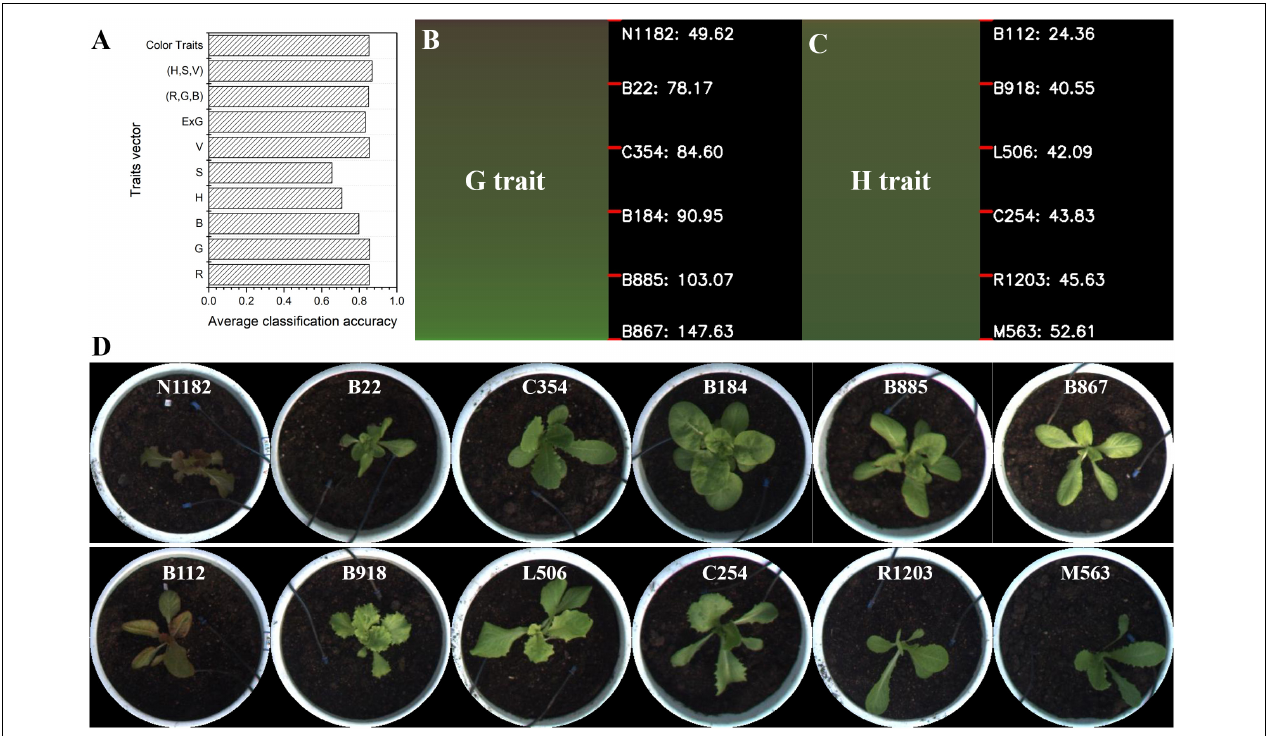
FIGURE 9 | Color grading of lettuce varieties. (A) The average classification accuracy of 10 kinds of feature vector combinations based on the kNN algorithm. (B) Color grading chart of lettuce varieties based on the color trait G. (C) Color grading chart of lettuce varieties based on the color trait H. (D) Sorted lettuce varieties with different color grades quantified by G and H,